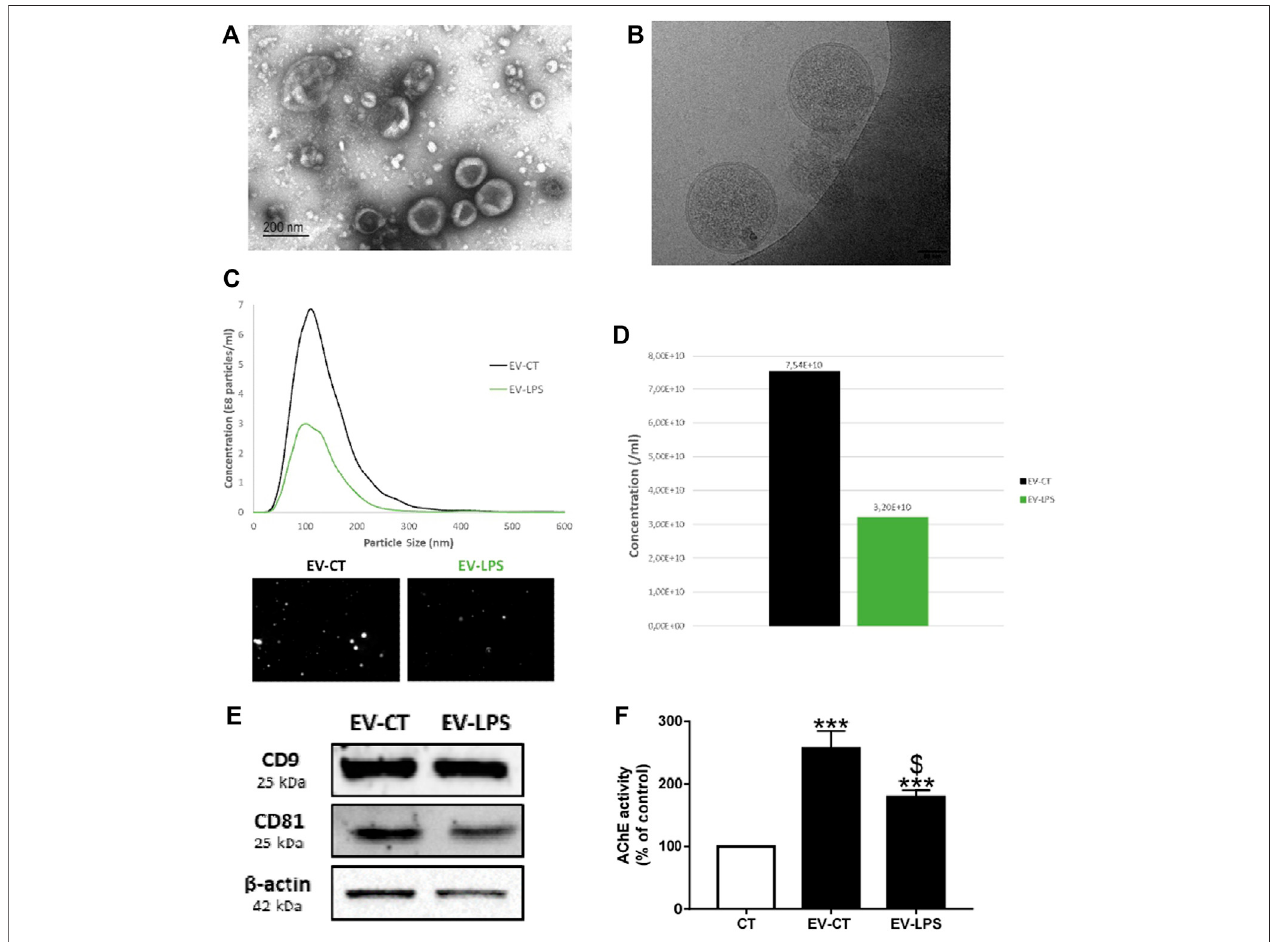
FIGURE5| Characterizationofmacrophage-derivedEVs.EVswereisolatedfromtheculturemediaofRAWcellsincubatedwith(EV-LPS)orwithout(EV-CT)1 µg/ mllipopolysaccharide-EK(LPS-EK)for6 h.EvaluationofEVmorphologyby (A) transmissionelectronmicroscopy(TEM)and (B) cryo-electronmicroscopy(cryo-EM). (C) Particle-sizedistributionand (D) thetotalconcentrationofmacrophage-derivedEVsweremeasuredbynanoparticle-trackinganalysis(NTA). (E) CD9,CD81,and β -actin protein expression were assessed by western blotting. (F) Quanti fi cation of the enzymatic activity of acetylcholinesterase (AChE) in macrophage-derived EVs. ControlAChEactivityintheassaydiluent1X-D-PBS(CT)wasde fi nedas100%.Dataareexpressedasthemean±SEMofsevenindependentexperimentsperformedin triplicate ( n = 7). *** p < 0.001 vs . CT; $ p < 0.05 vs. EV-CT, Mann-Whitney test.